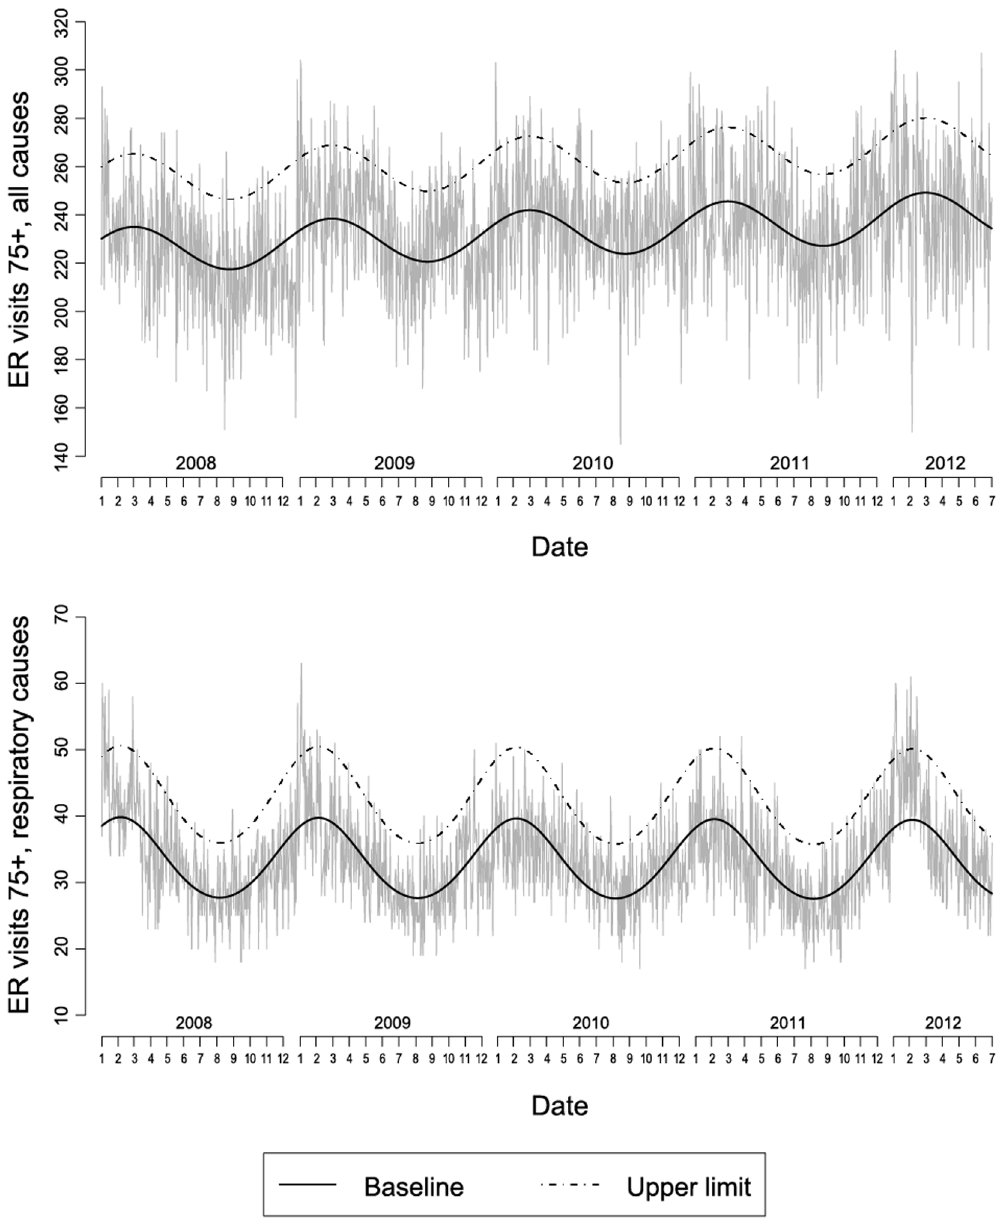
Figure 3. Daily trend (January 2008–June 2012) in ER visits for all causes and respiratory causes among the very old (75 years and over) in